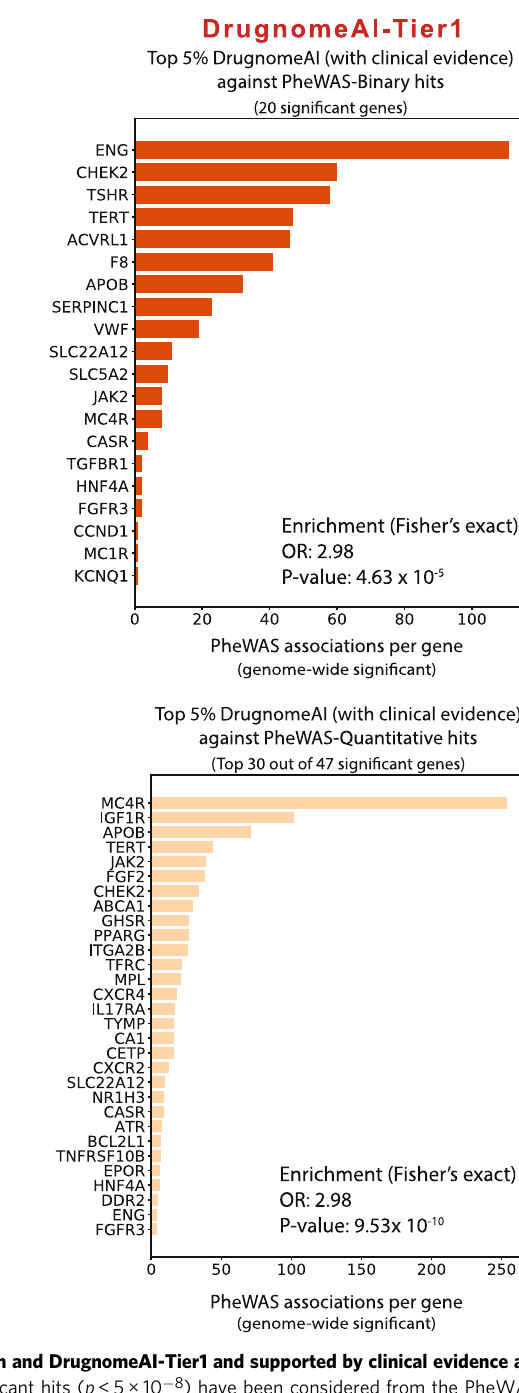
exact test p value = 3.9 × 10 − 15 , Odds Ratio = 2.3), Yu et al. (Fisher ’ s exact test p value = 3.6 × 10 − 79 , Odds Ratio = 17.2), and Costa et al. (Fisher ’ s exact test p value = 2.3 × 10 − 10 , Odds Ratio = 1.9) with the same validation dataset (Supplementary Data 7).